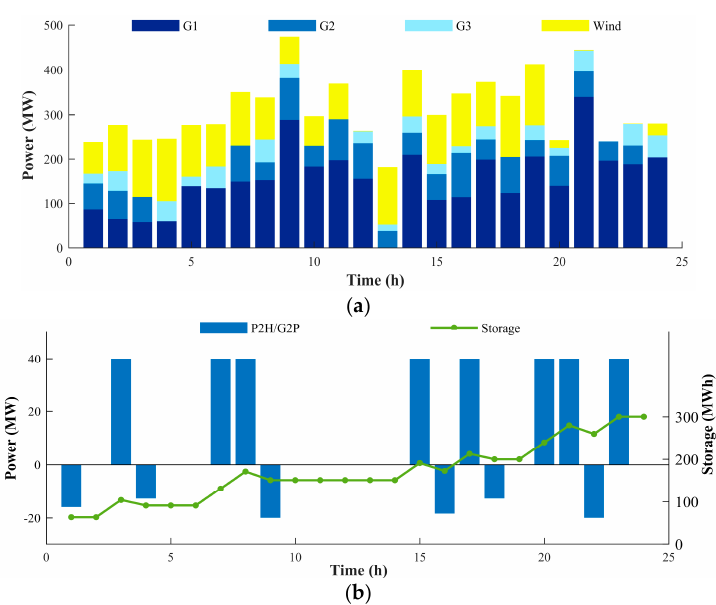
Figure 10. Dispatch result in Case 3. ( a ) Outputs of conventional generators and the wind turbine. ( b ) Output of the P2H/G2P plant.